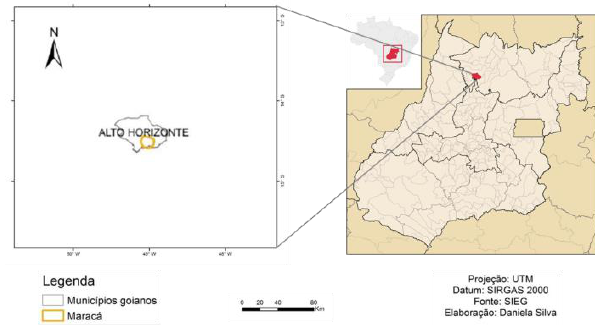
Figure 1. Location map of the municipality and mineral enterprise.